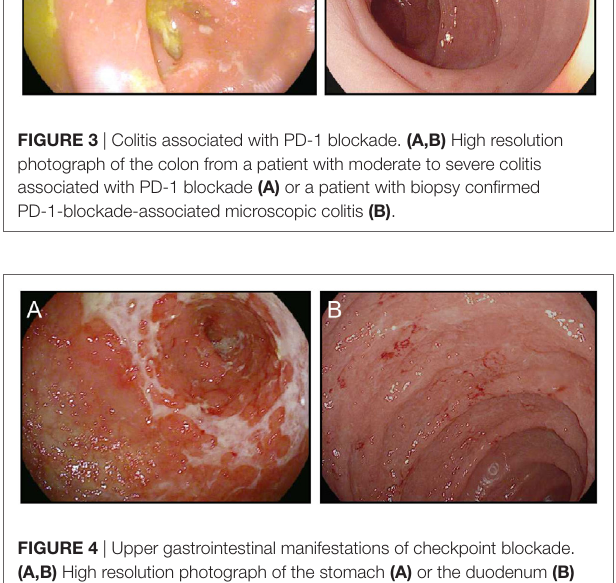
FiGURe 4 | Upper gastrointestinal manifestations of checkpoint blockade. (a,B) High resolution photograph of the stomach (a) or the duodenum (B) from a patient with severe checkpoint blockade-associated gastritis (a) or enteritis (B) .